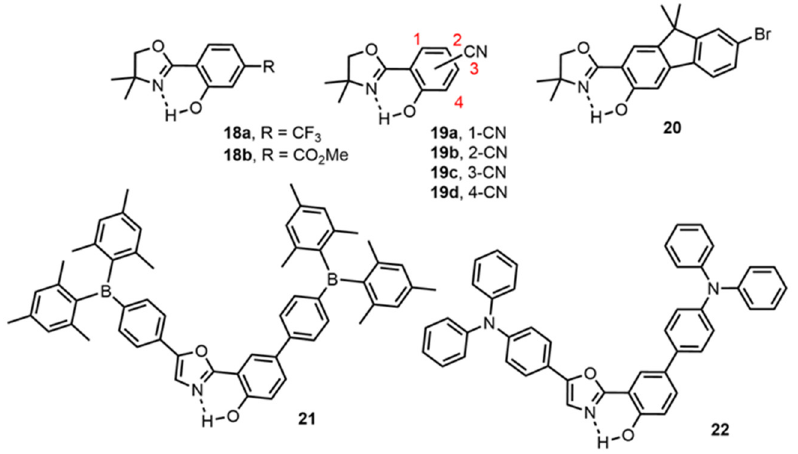
Figure 6. DSE/ESIPT fluorophores based on an oxazole scaffold [72,79–81]. Göbel et al. studied the influence of electronic substitution in 2-(oxazolinyl)-phenol derivatives 18a–b , as minimalistic ESIPT fluorophores. In particular, the introduction of strong electrowithdrawing substituents (CF 3 , CO 2 Me) at the para position of the oxazoline triggered intense fluorescence, as compared to other substituents or other substitution positions on the π -conjugated scaffold [79]. The same group also reported ni- trile-substituted 2-(oxazolinyl)-phenols dyes 19a–d where subtle modifications, e.g., the position of the nitrile substituents induced different effects [80]. Although all dyes dis- played significant emission intensity in both solution and solid, dyes 19a–b showed ag- gregation-induced emission enhancement (AIEE) behavior, while 19d featured ACQ characteristics. The introduction of a fused fluorene moiety of the proton donor side en-